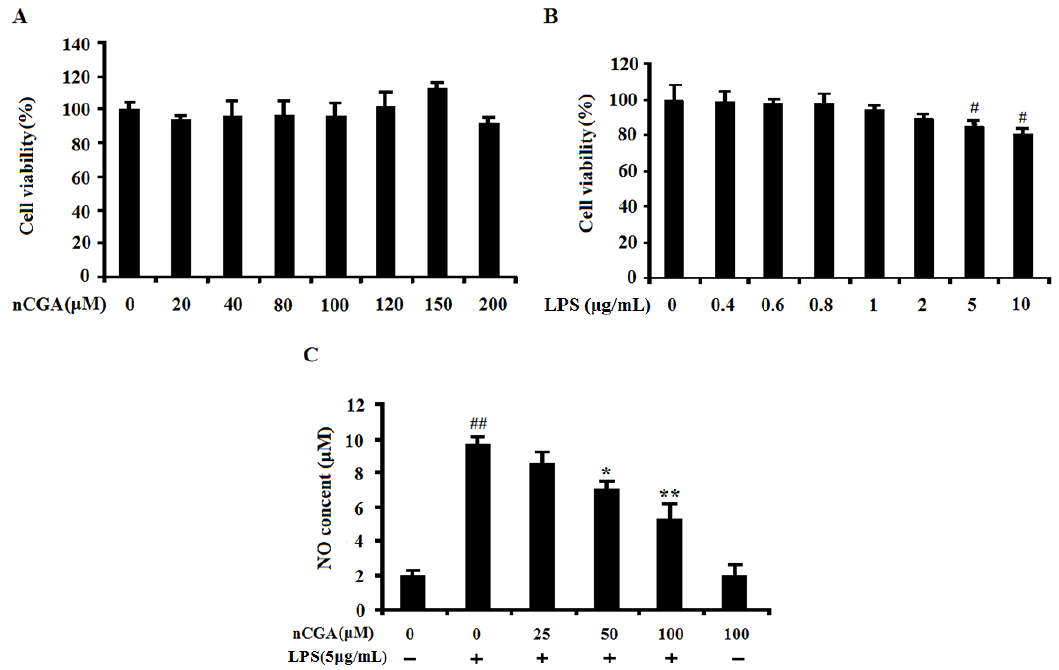
Figure 1. E ff ects of Neochlorogenic acid (nCGA) on cytotoxicity of A549 cells. ( A ) A549 cells were incubated with various concentrations of nCGA (0 to 200 µ M) for 24 h, the cytotoxicity was measured by MTT assay. ( B )A549 cells were treated with di ff erent concentration of LPS for 24 h, the cell viability was measured by MTT assay, the optimum concentration of LPS was selected for further study. ( C ) A549 cells were pretreated with or without various concentrations of nCGA (0, 25, 50, 100 µ M) for 2 h before LPS (5 µ g / mL) stimulation for another 24 h, the level of NO was measured in the culture medium by Griess reagents. The values represent the mean ± SD of three independent experiments, significant di ff erences between di ff erent groups. # p < 0.05, ## p < 0.01 vs. control group, * p < 0.05, ** p < 0.01 vs. LPS alone